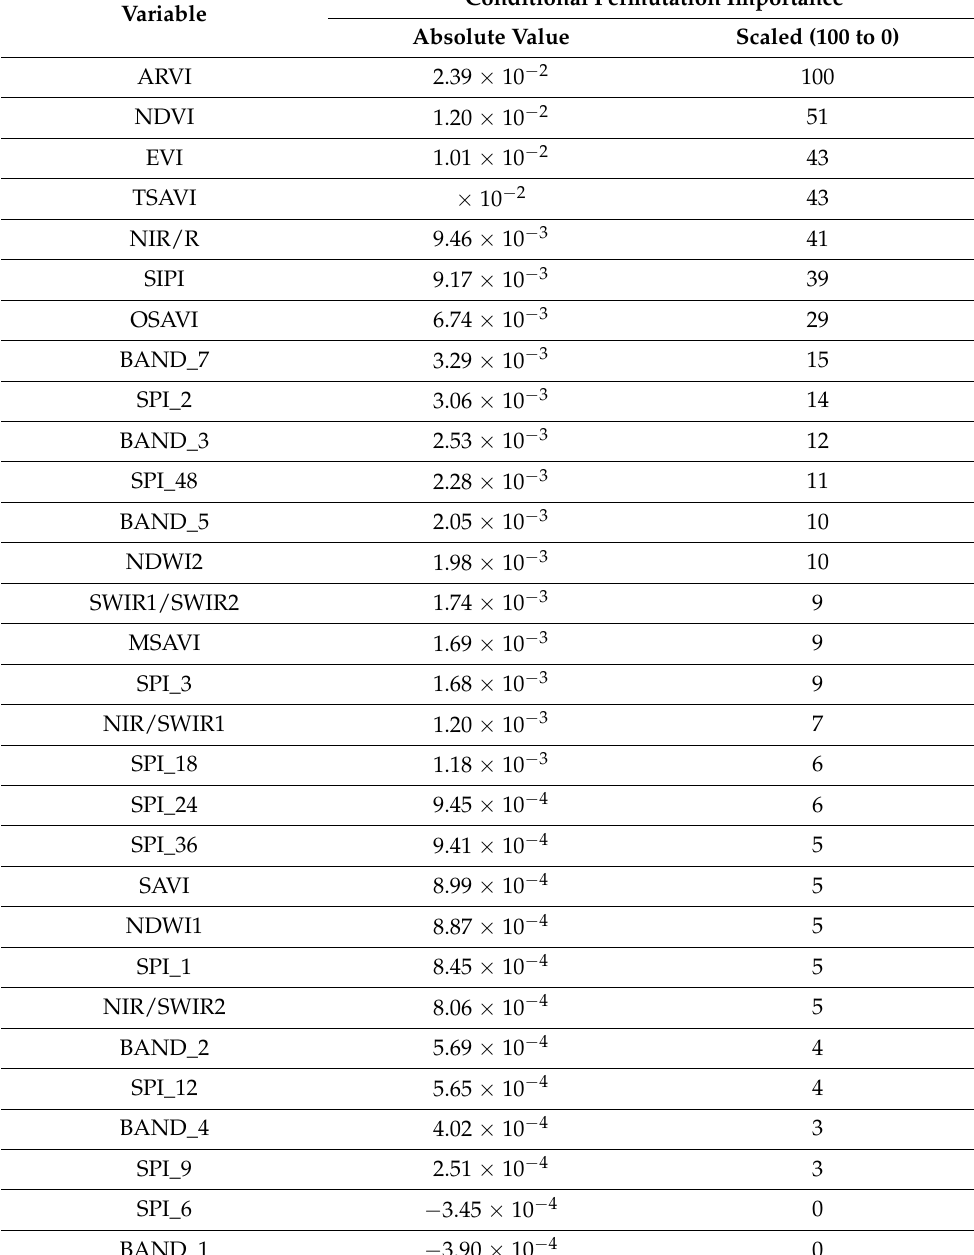
Table 4. Conditional permutation importance for the model: absolute and relative (scaled from 100 to 0)